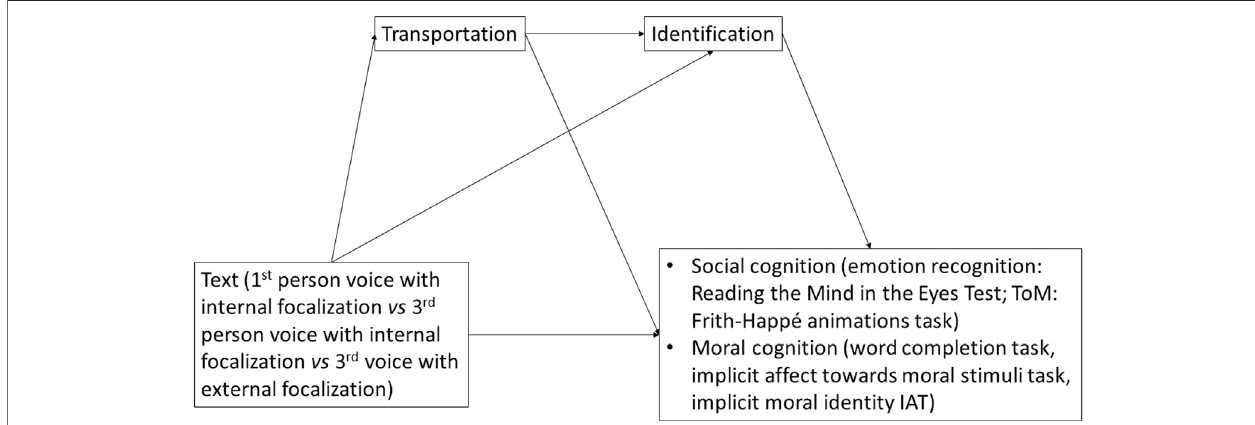
FIGURE 1 | Predicted relationships between the variables of interest and their